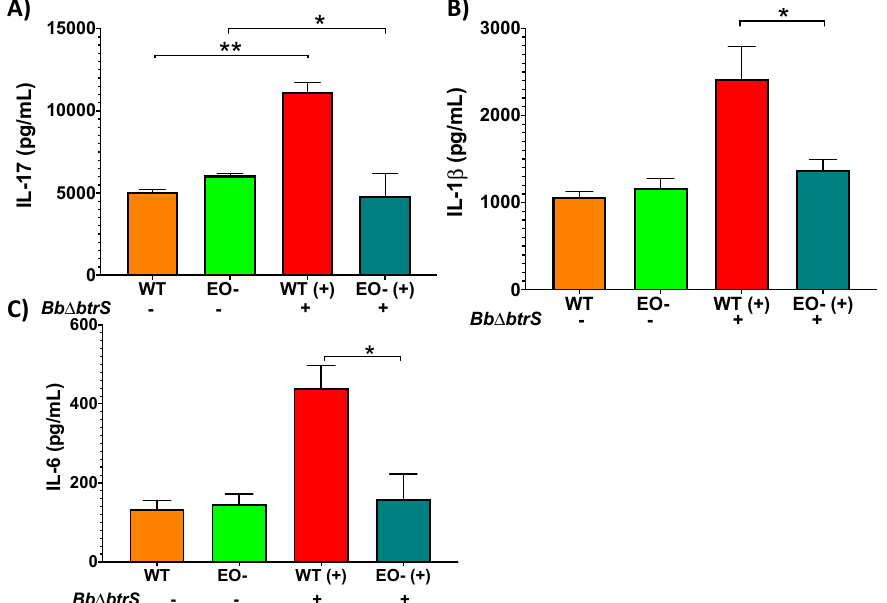
Figure 3. Eosinophil-deficient mice failed to secrete IL-17, IL-1 β , and IL-6. Groups of mice were intranasally challenged with 50 μ L of PBS, or PBS containing 5 × 10 5 Bb D btrS ; they were euthanized on day 7 ( A , B ) or 14 ( C ) post-challenge, and trachea was collected and homogenized, to perform ELISA. The graphs show the average and SEM. * p < 0.05 and ** p < 0.01, using two-way ANOVA. n = 6.